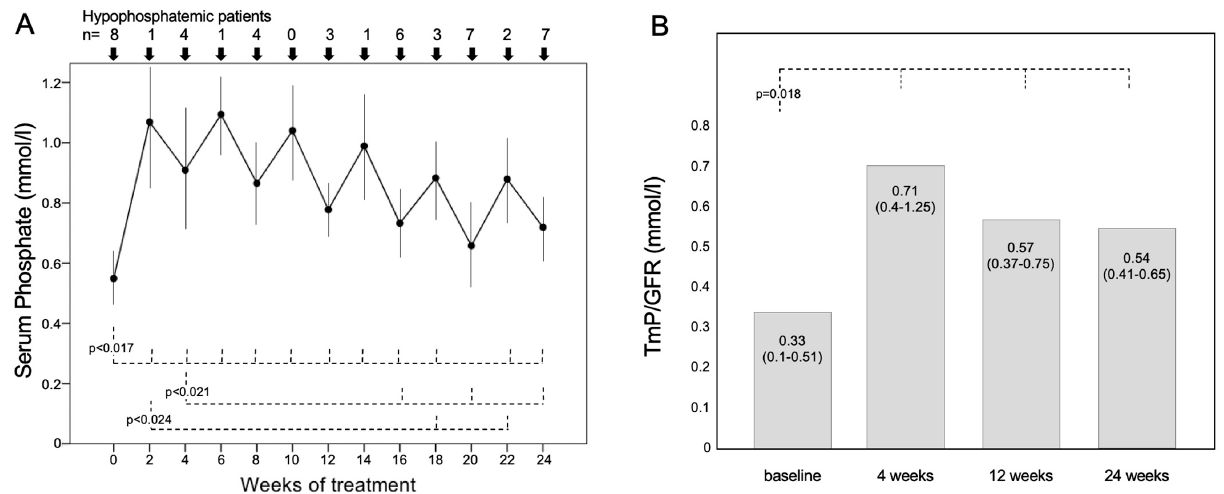
Figure 1. ( A ) Values of phosphatemia during 24 weeks of treatment with burosumab in 8 patients with XLH. Variables are reported as mean ± SD. The drug was injected subcutaneously (1 mg/kg body weight), and serum phosphate was measured two and four weeks after each burosumab injection. The number of patients with serum phosphate below the normal range is reported in the upper part of the figure. ( B ) Values of TmP/GFR measured in 7 XHL patients at the baseline and after 4, 16 and 24 weeks of treatment with burosumab.